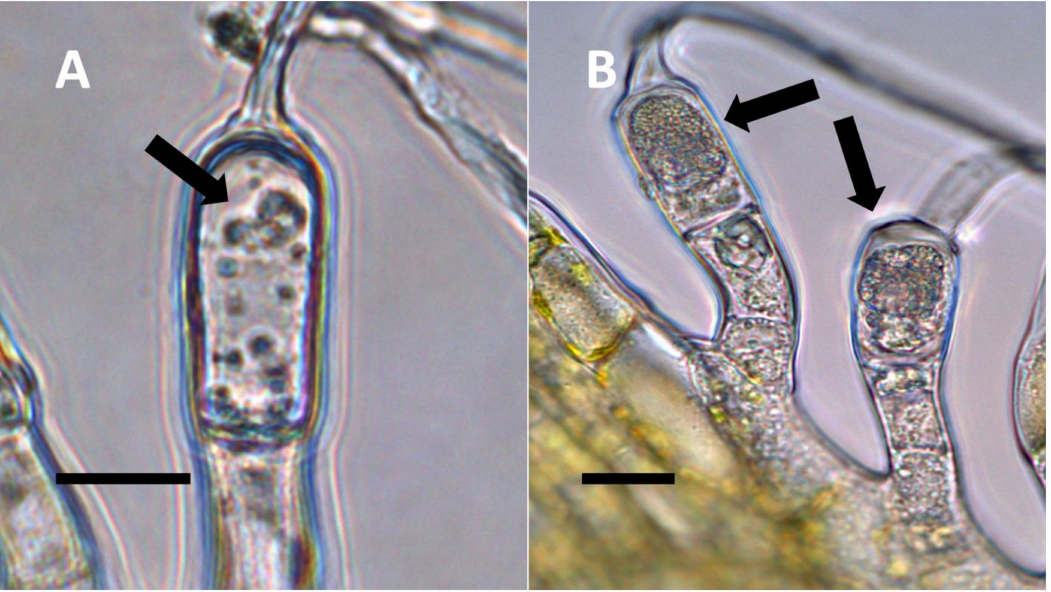
Figure 6. Solidago canadensis inflorescence bract non-pitted trichomes. ( A ) Developing trichome stained with acidified diphenylamine showing nitrate (blue color) around bacteria (arrow) in hair (Bar = 10 µ m). ( B ) Trichome stained with acidified diphenylamine showing nitrate (blue color) around bacterial masses (arrows) (Bar = 10 µ